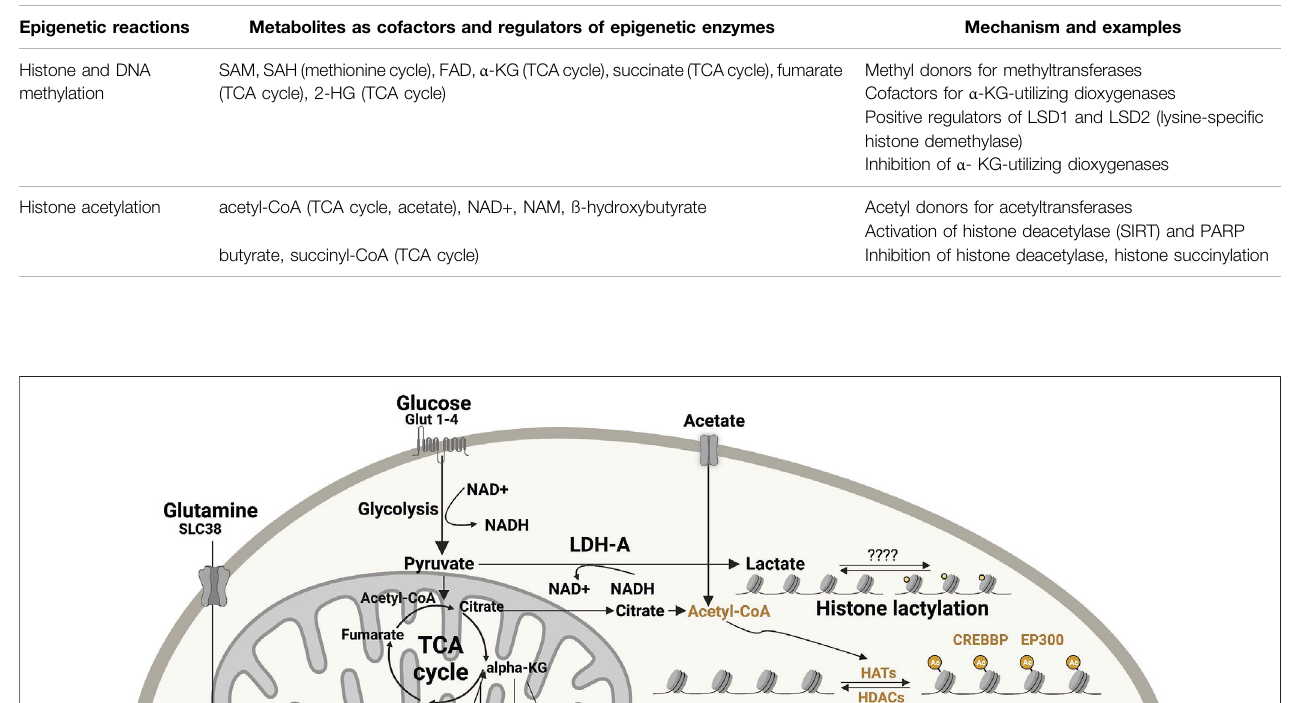
( Figure 1 ). Acetyl-CoA, which is synthetized from glucose oxidation to pyruvate through pyruvate dehydrogenase (PDH), or from fatty acid ß-oxidation and acetate, metabolically sustains ATP production under aerobic condition and several biosynthetic processes. When not needed for these downstream metabolic processes, acetyl-CoA can diffuse from cytoplasm to the nucleus or can be locally produced in the nucleus (Nitsch et al., 2021), thus becoming available as substrate for HATs to modify histone